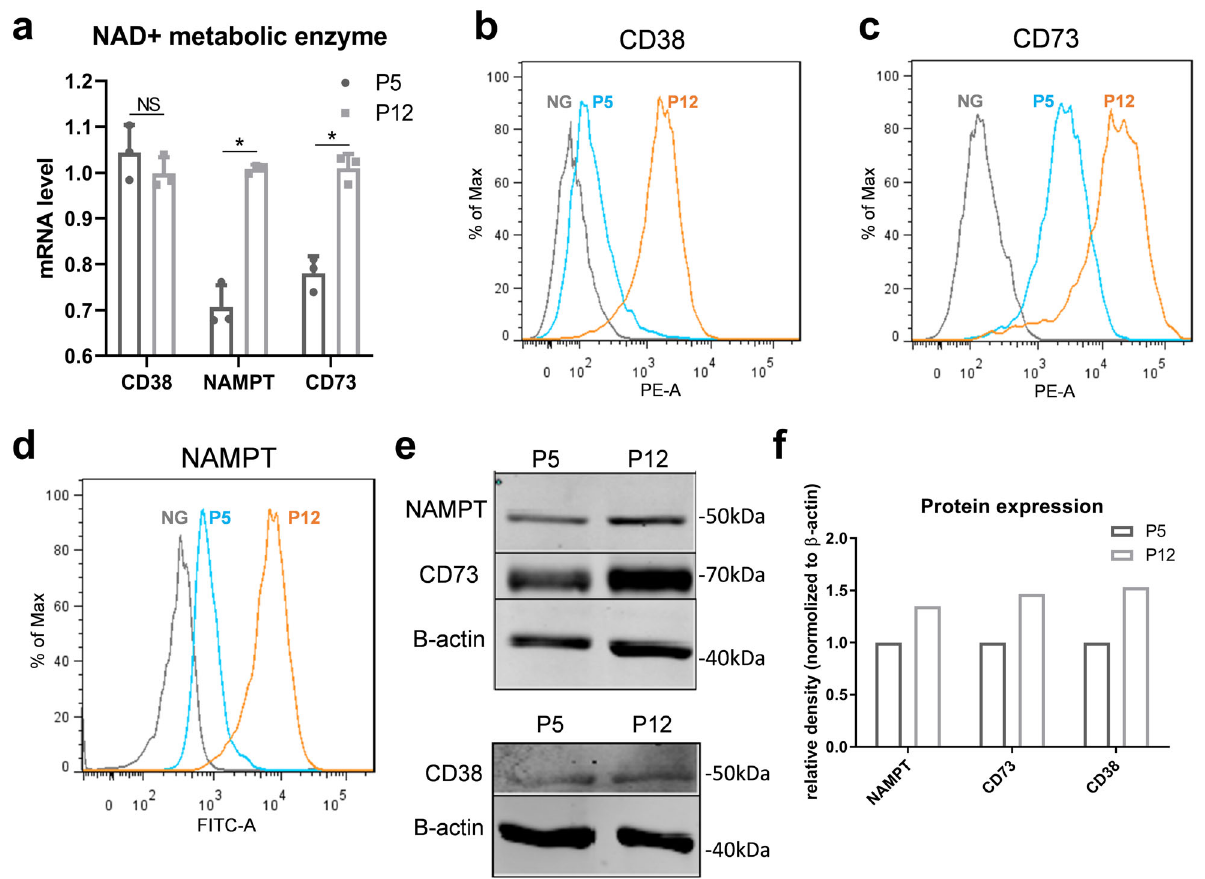
Fig. 5 In vitro culture expansion of human mesenchymal stem cells (hMSCs) alters NAD + biogenesis and metabolism. a mRNA levels of NAD + metabolic enzymes NAMPT, CD38 , and CD73 in hMSCs at early and late passage. b NAMPT, c CD38, and d CD73 protein expressions were all increased in late passage of hMSCs determined by fl ow cytometry. NG negative control. e , f Western blot con fi rmed the increase of NAMPT, CD38, and CD73 in late passage of hMSCs. Biological replicates ( n ): n = 3. * p < 0.05. NS not statistically signi fi